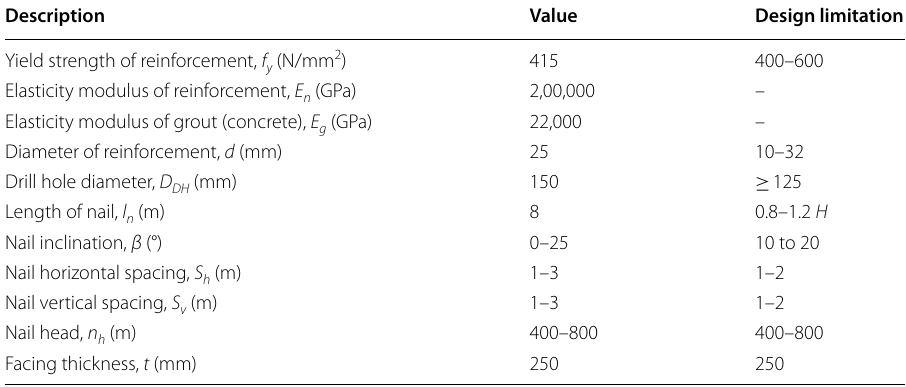
Table 3 Soil nail parameters